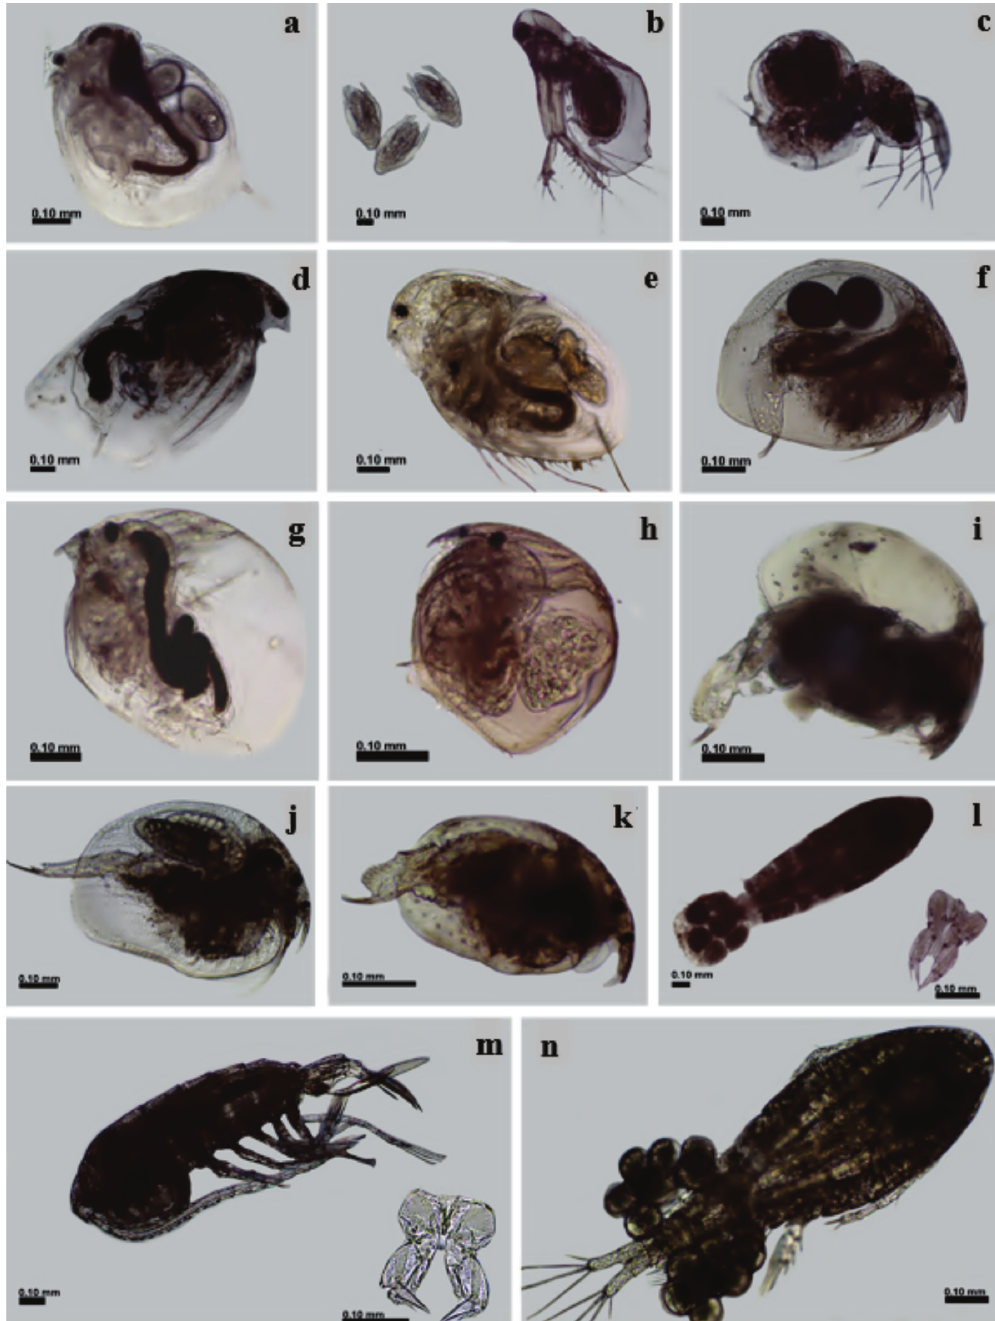
Figure 3 - Microcrustaceans (Cladocera and Copepoda) recorded in the three reservoirs in a tropical semiarid basin (Pajeú river). a , Ceriodaphnia cornuta Sars, 1886; b , Diaphanosoma spinulosum Herbst, 1967; c , Moina micrura Kurz, 1874; d , Simocephalus latirostris Stingelin, 1906; e , Macrothrix elegans Sars, 1901; f , Leberis davidi (Richard, 1895); g , Dunhevedia odontoplax Sars, 1901; h , Ephemeroporus hybridus (Daday, 1905); i , Karualona muelleri (Richard, 1897); j, Kurzia polyspina Hudec, 2000; k, Anthalona verrucosa (Sars, 1901); l, Notodiaptomus cearensis (Wright, 1936) - with detail of the fifth leg; m, Notodiaptomus iheringi (Wright, 1935) - with detail of the fifth leg; n, Thermocyclops decipiens (Kiefer,